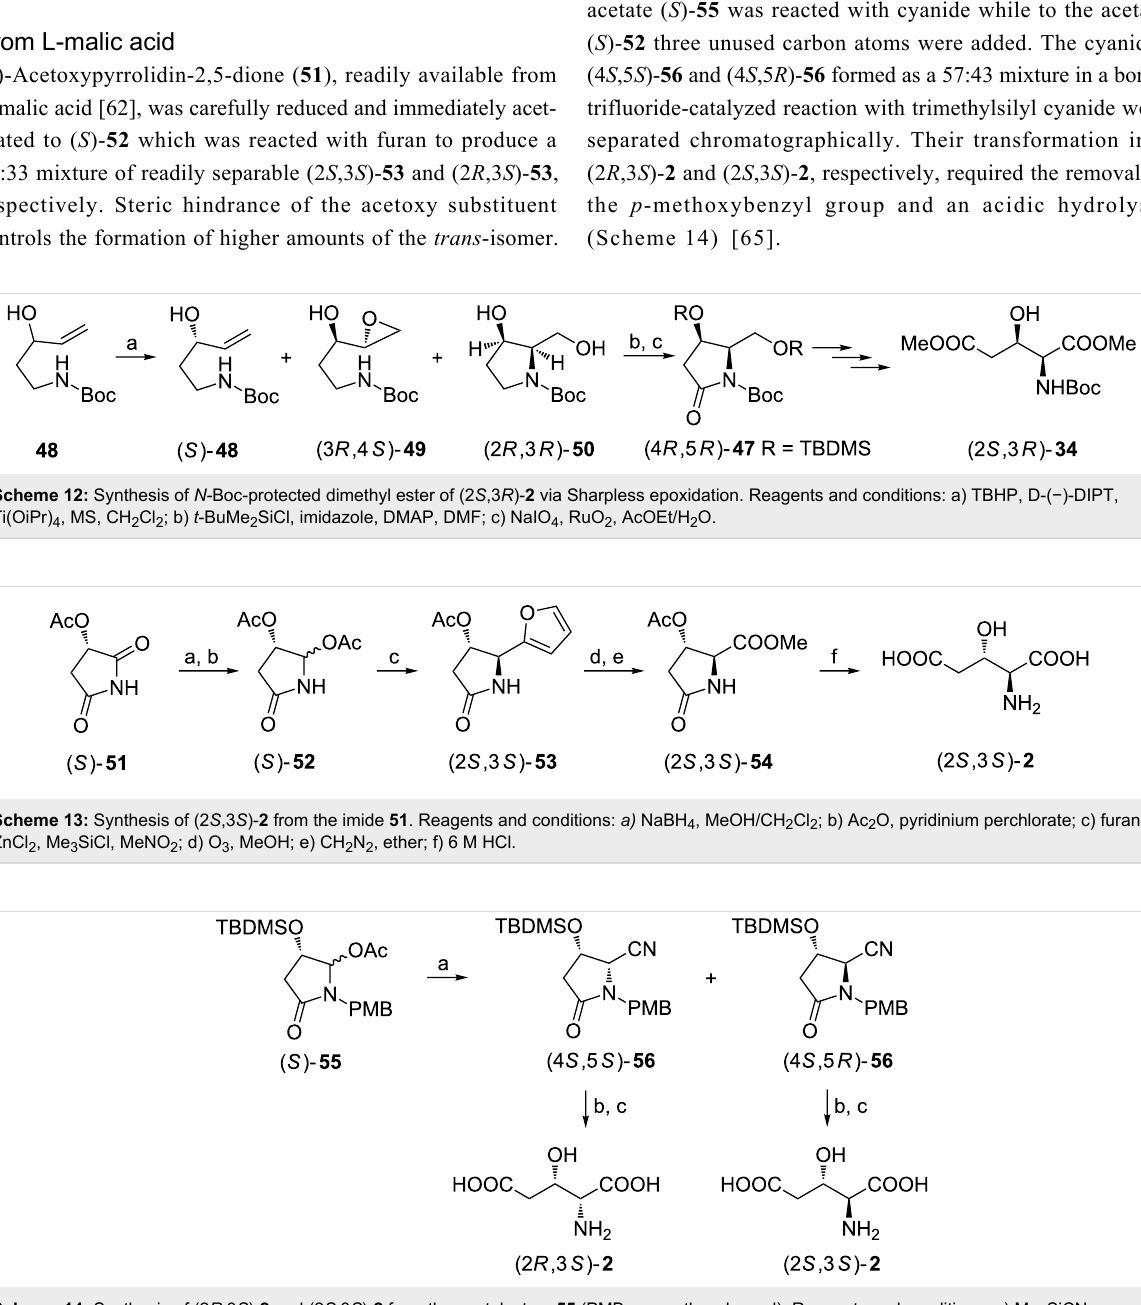
Scheme 14: Synthesis of (2 R ,3 S )- 2 and (2 S ,3 S )- 2 from the acetolactam 55 (PMB = p -methoxybenzyl). Reagents and conditions: a) Me 3 SiCN,